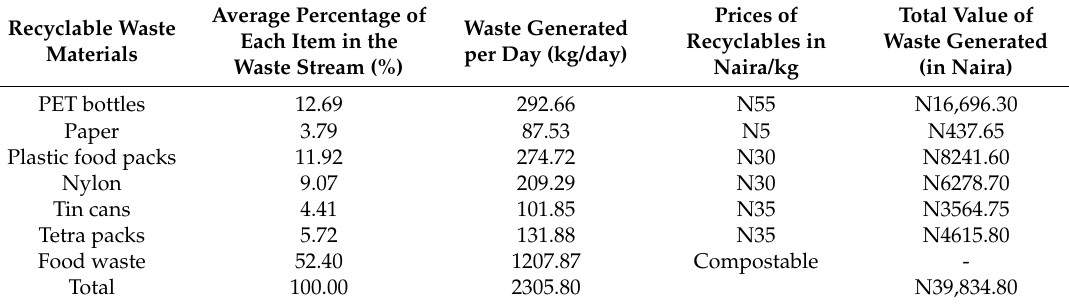
Table 9. Economic value from recycling waste